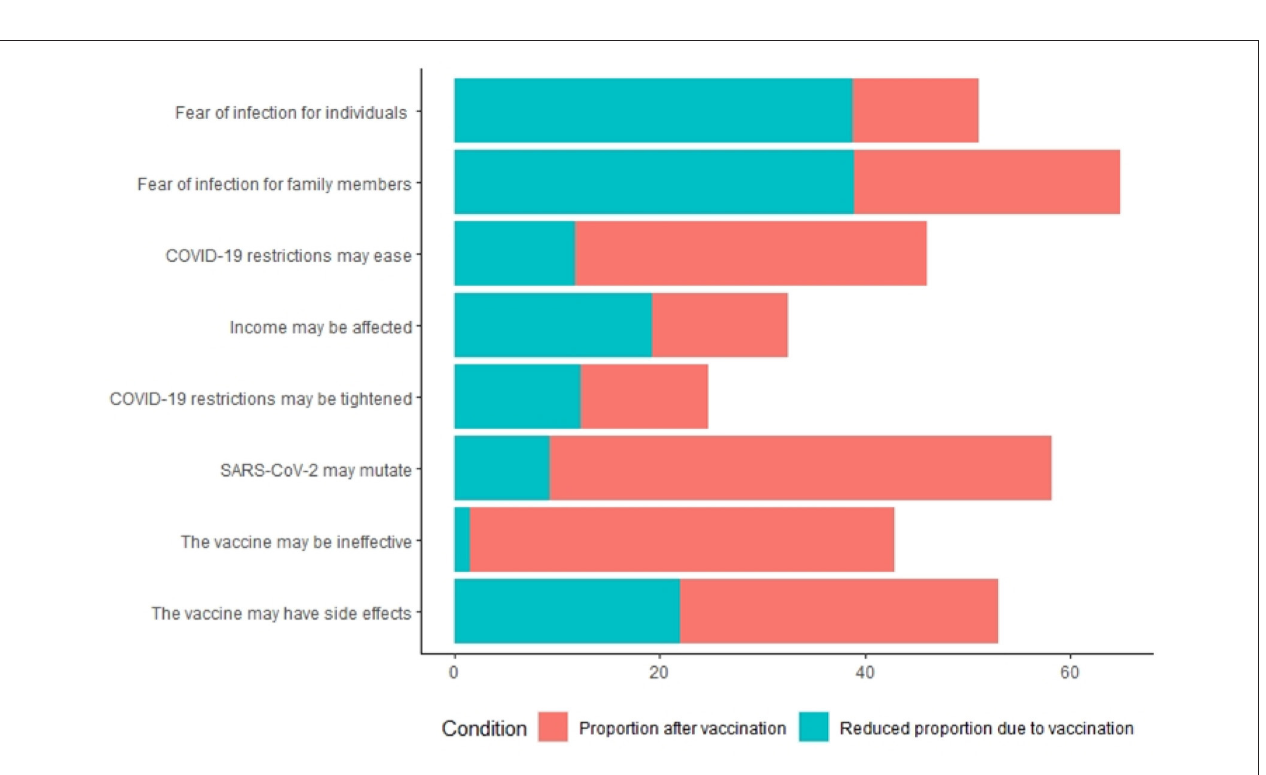
Frontiers in Public Health |